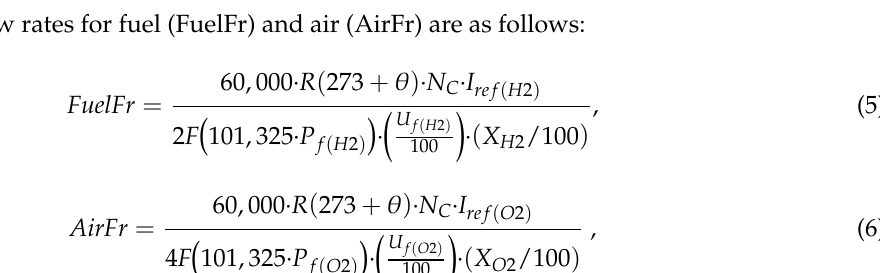
Figure 2. The diagram of the compressor model.